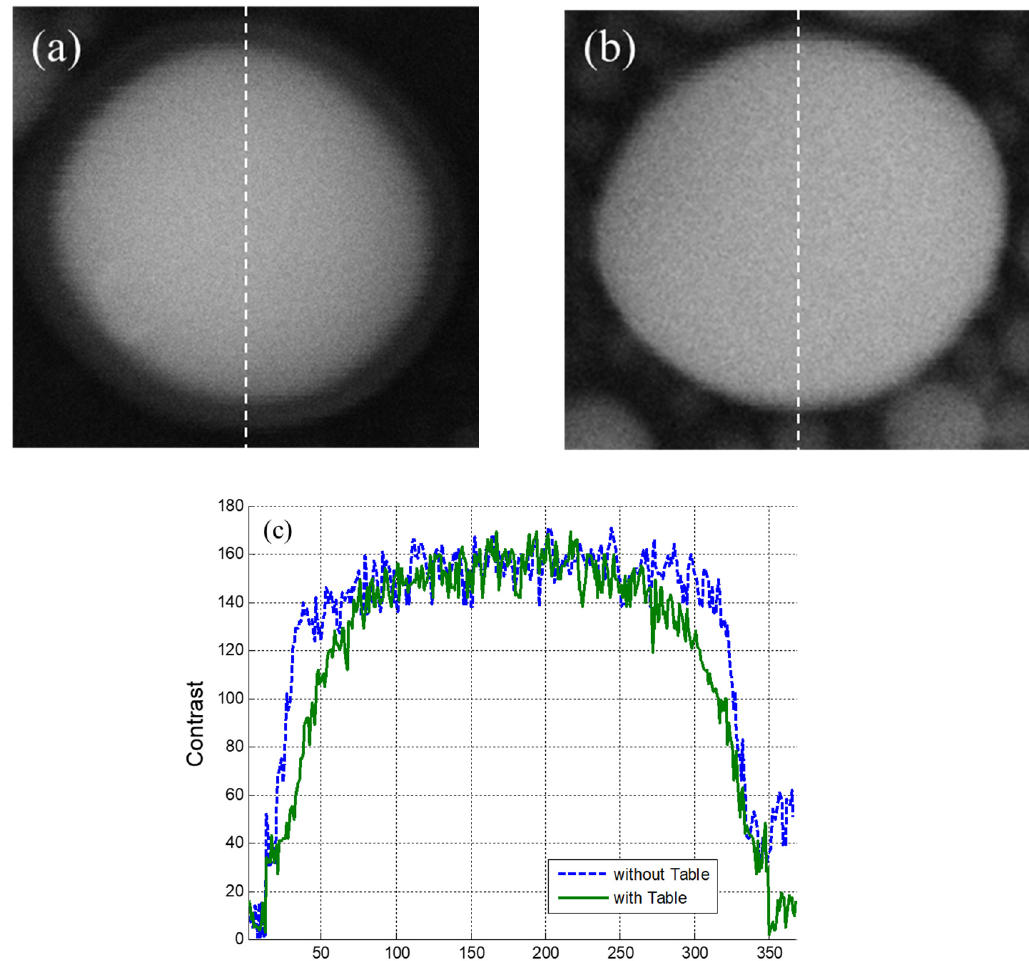
Figure 5. Measurement results for specimen patterns obtained ( a ) with and ( b ) without a table; ( c ) contrast variation along the specimen pattern images.